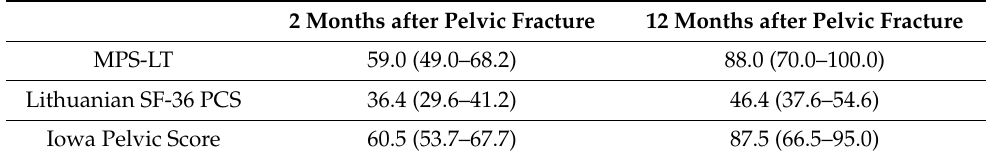
Table 2. Overall results of the Lithuanian version of the Majeed Pelvic Score, Lithuanian SF-36 Physical Component Summary (PCS), and the Iowa Pelvic Score between time-points. Data are presented as median